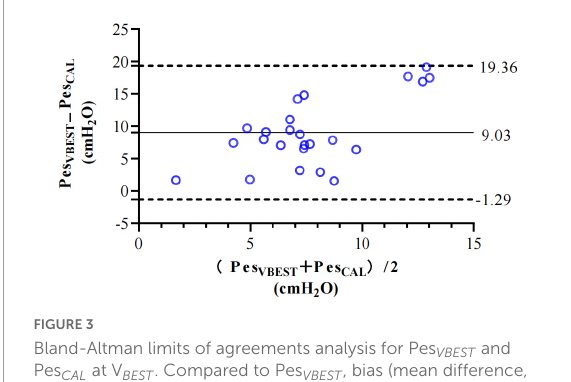
FIGURE3 Bland-Altman limits of agreements analysis for Pes VBEST and Pes CAL at V BEST . Compared to Pes VBEST , bias (mean difference, continuous line) and precision ( ± 1.96 SD of the difference, dotted lines) of Pes VCAL were 9.03 ± 10.33 cm H 2 O.